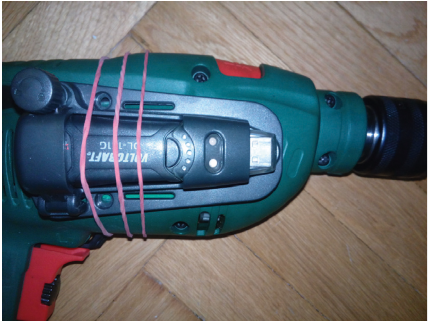
Figure 1: Healthy CM (rotor speed